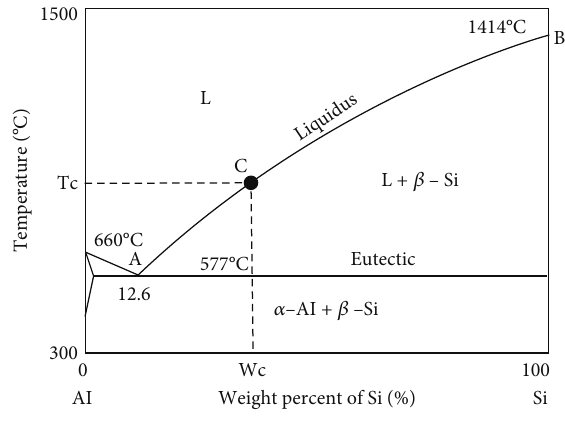
Figure 7: Al-Si phase